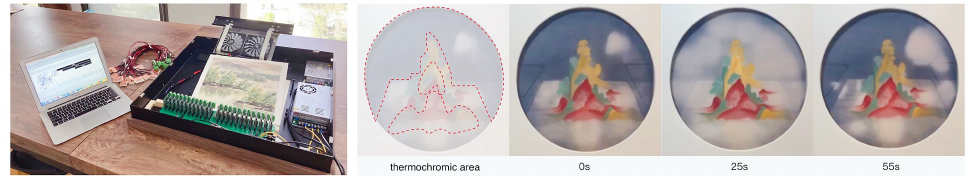
Figure 1. The left picture shows the ViviPaint toolkit. The four pictures on the right show the thermochromic area and three animation frames of the appearance and disappearance of